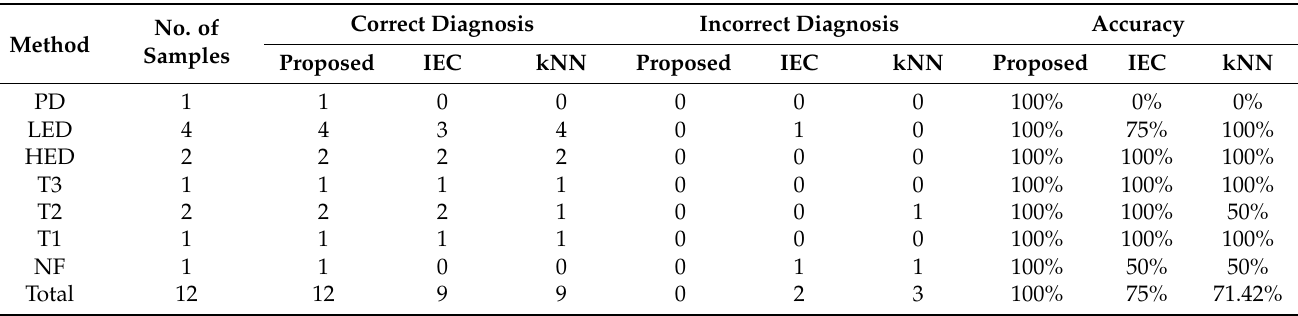
Table 5. Case study accuracy